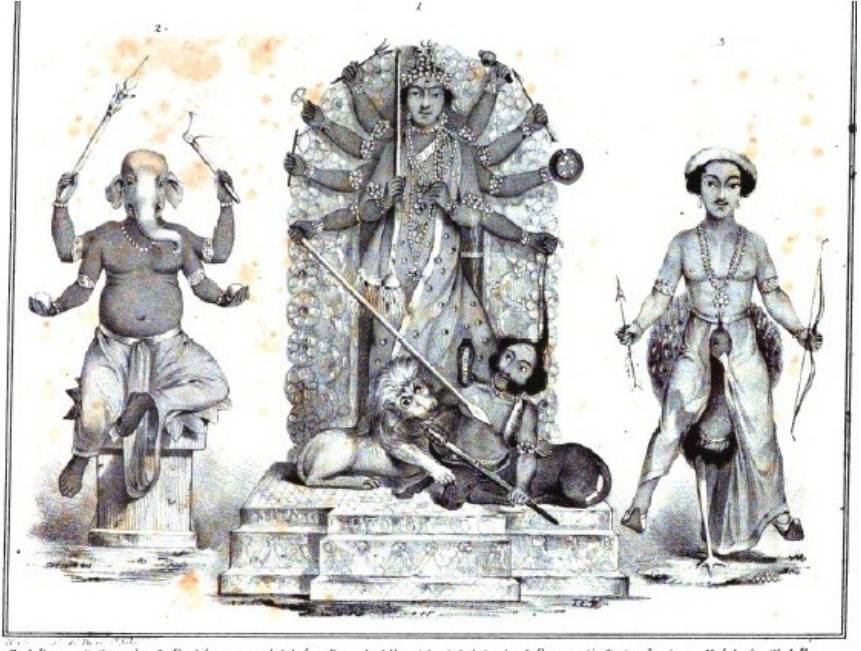
Figure 5. Charles Coleman, Frontispiece from The Mythology of the Hindus